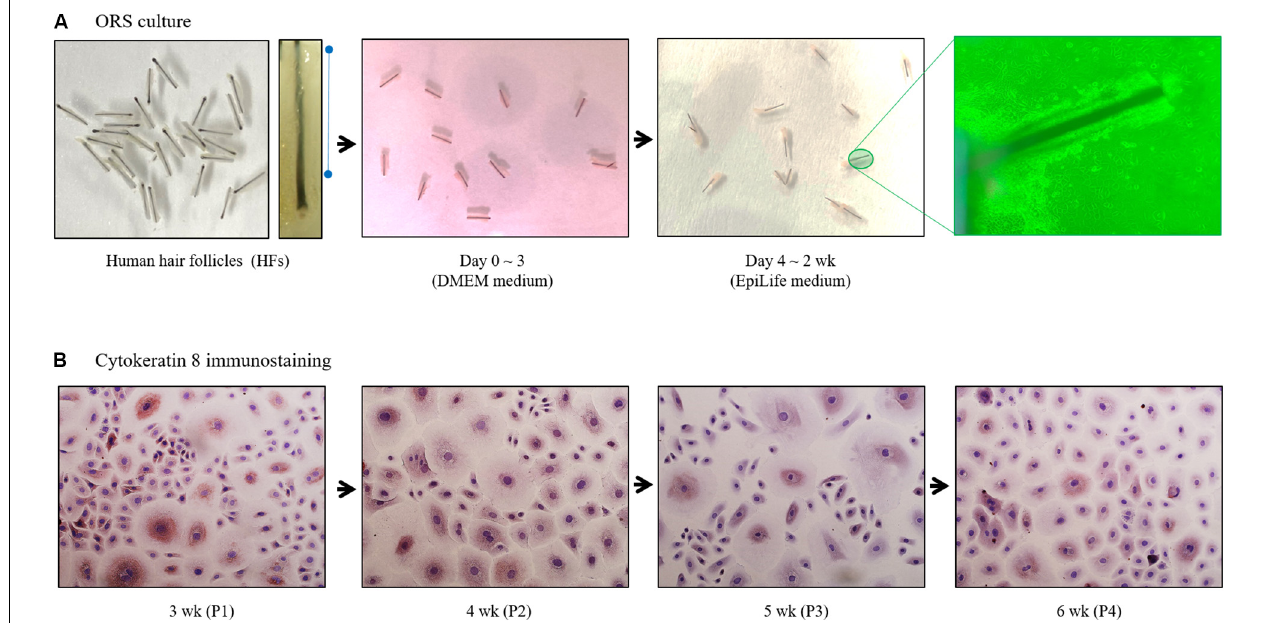
FIGURE 1 | Diagram of human outer root sheath (ORS) follicular keratinocytes cultivation. (A) Human ORS cells were cultured as described in the Materials and Methods section. Representative images from a patient (male, age 37 years) are shown. (B) Cells in various culture periods (3, 4, 5, and 6 weeks) from a patient (male, age 28 years) were immunostained with cytokeratin 8